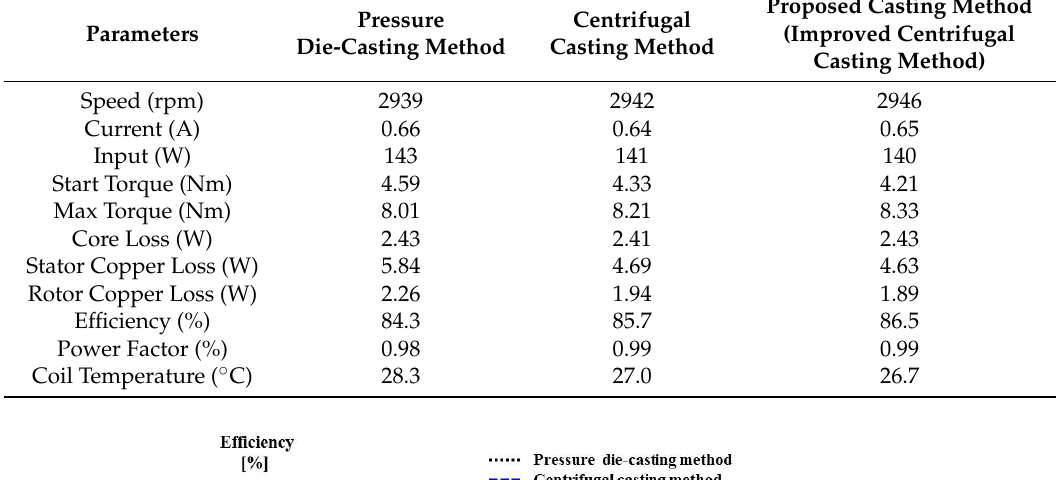
Table 6. The results of applying the stator #1 (220 V/50 Hz).